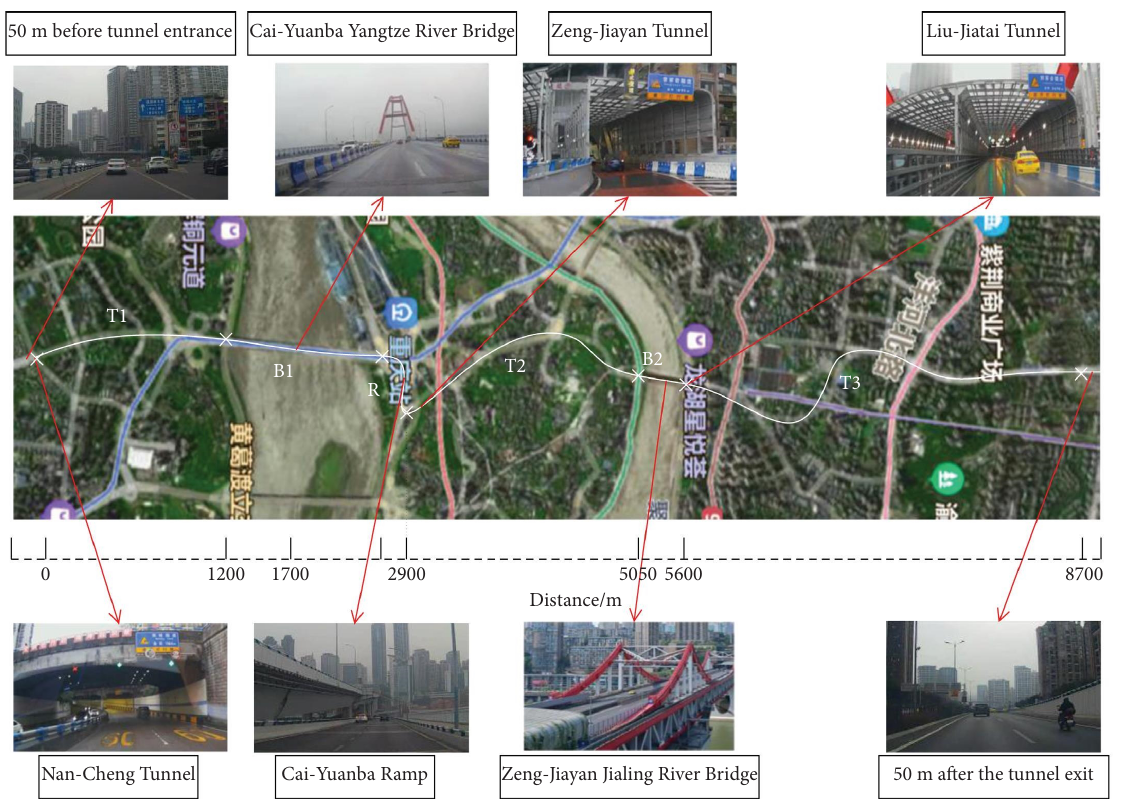
Figure 2: Te alignment and driving environment of the experimental